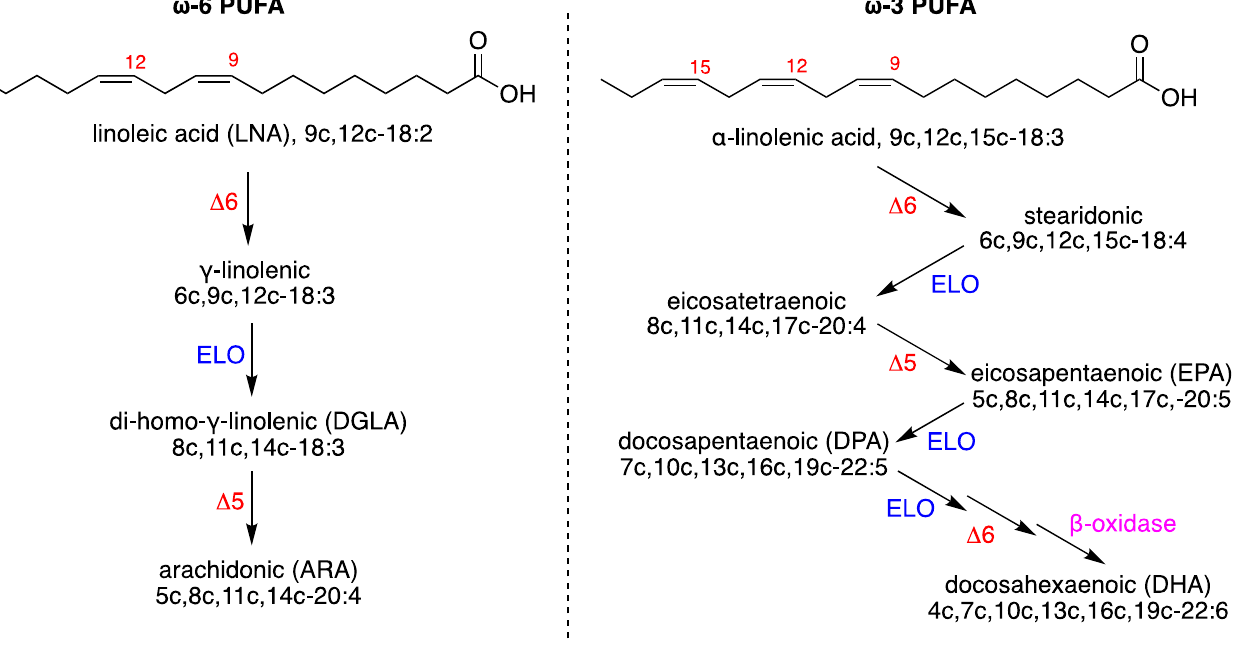
Figure 2. Biosynthesis of PUFA: ( left ) the omega-6 series starting linoleic acid; ( right ) the omega-3 series starting alpha-linolenic acid. Enzymes: ELO elongase; Δ 5-, Δ 6-, and Δ 9-desaturase; β -oxidase. Numerical abbreviations describing the position and cis geometry of the double bonds (e.g., 9c), as well as the notation of the carbon chain length and total number of unsaturations (e.g., 18:2); in parentheses are the acronyms used in this work (e.g., ARA for arachidonic acid).